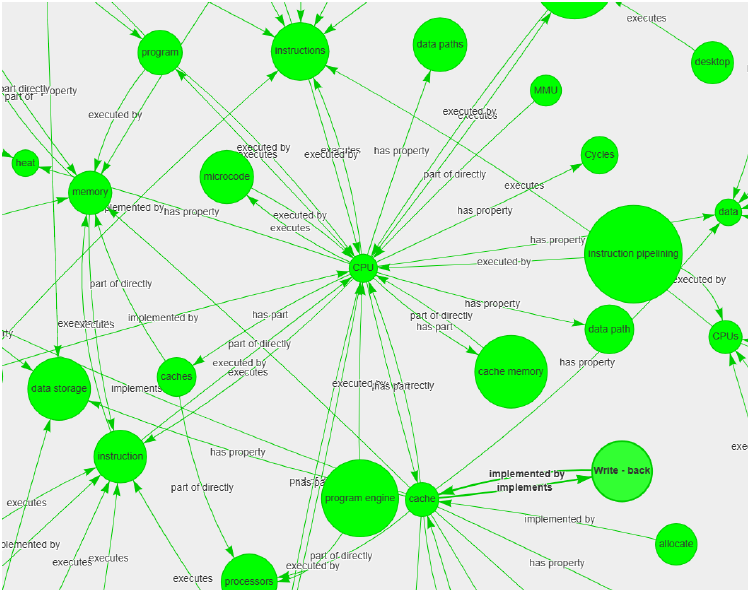
Figure 9. Knowledge graph generated on our test data using a transformer neural